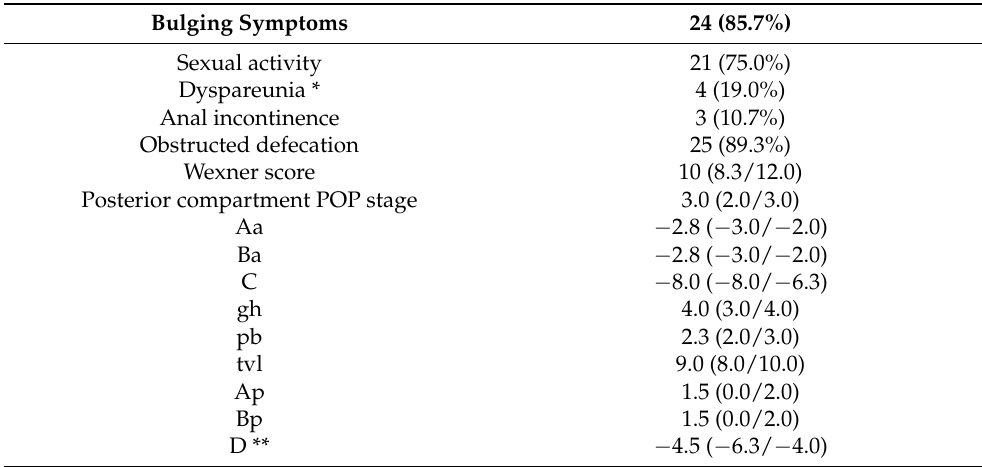
Table 2. Preoperative symptoms and prolapse stage. Data as absolute (relative) frequencies for categorical variables and median (interquartile range) for continuous ones; * only for sexually active patients; ** only for patients with uterus.